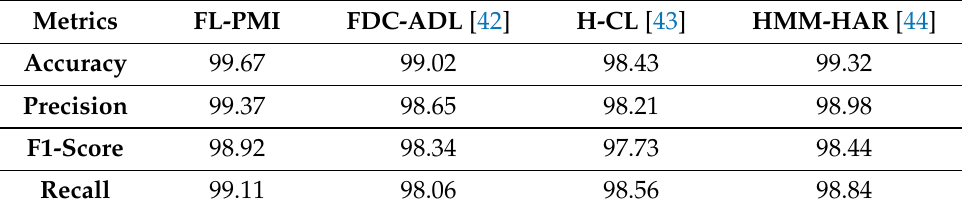
Table 2. Comparative analysis of FL-PMI with existing system, which used the same